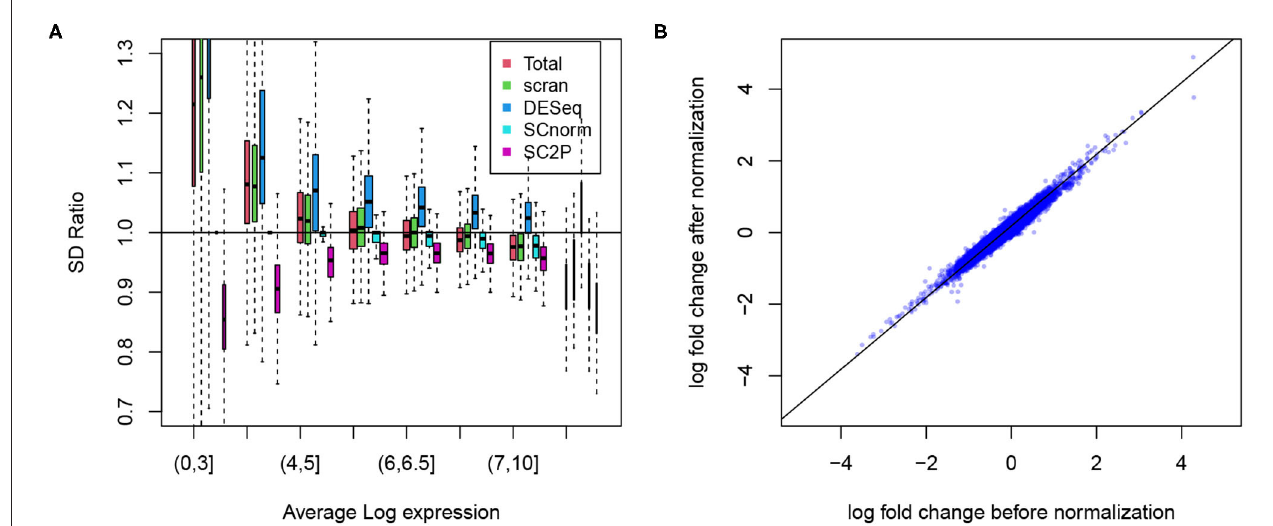
FIGURE 5 | (A) Reduction of the technical variability among replicate cells. The ratio of gene specific standard deviation in normalized log counts over that in the raw log counts plotted. Genes are displayed in different groups based on their average expression when they are expressed. (B) The log fold change between Alpha and Beta cell populations before and after normalization remains at similar